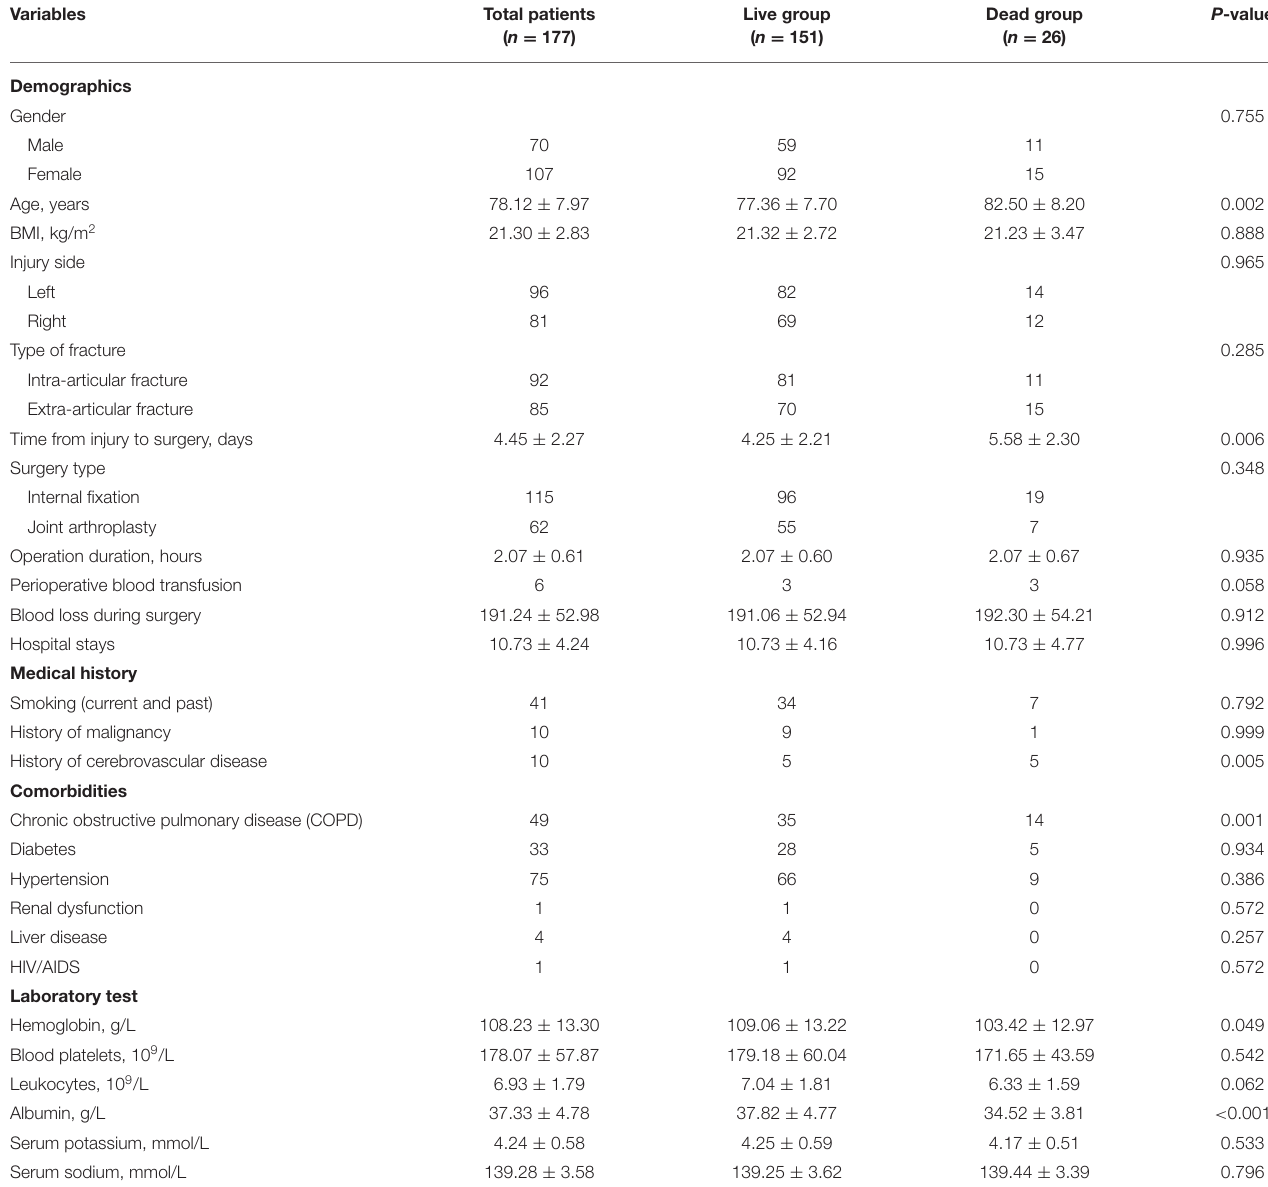
TABLE 4 | The baseline characteristics of the texting